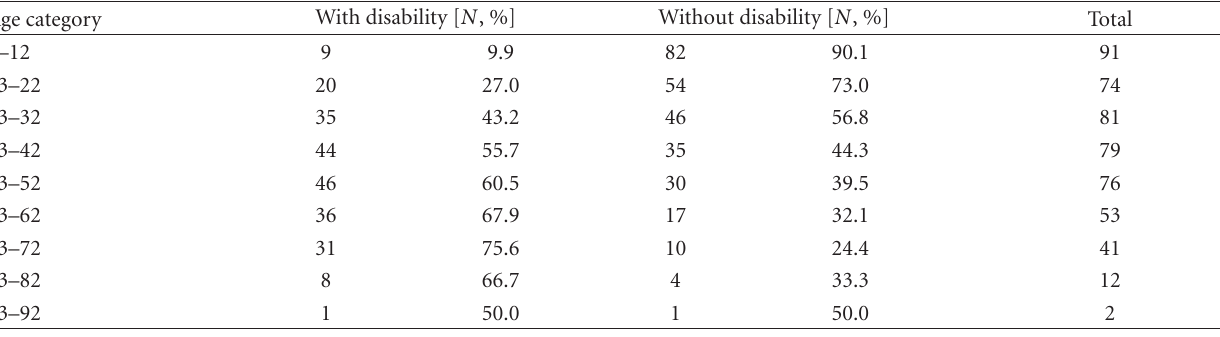
Table 3: Distribution of chronic arthritic disability in age groups.